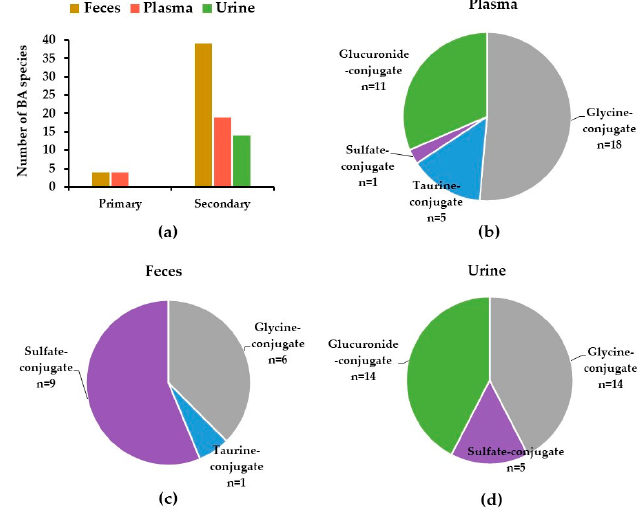
Figure 1. Distribution of BAs in human feces, plasma, and urine samples: ( a ) primary and secondary BAs; ( b – d ) different BAs subgroups, categorized based on their conjugates. Data are presented as number of BA species detected in each subgroup of BAs.